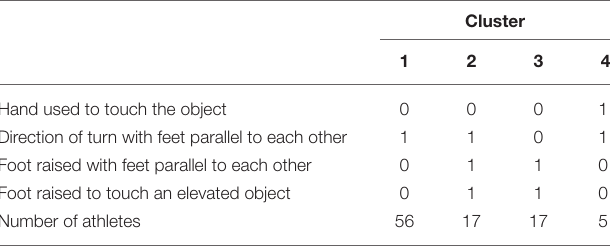
TABLE 4 | Laterality profiles and jumping